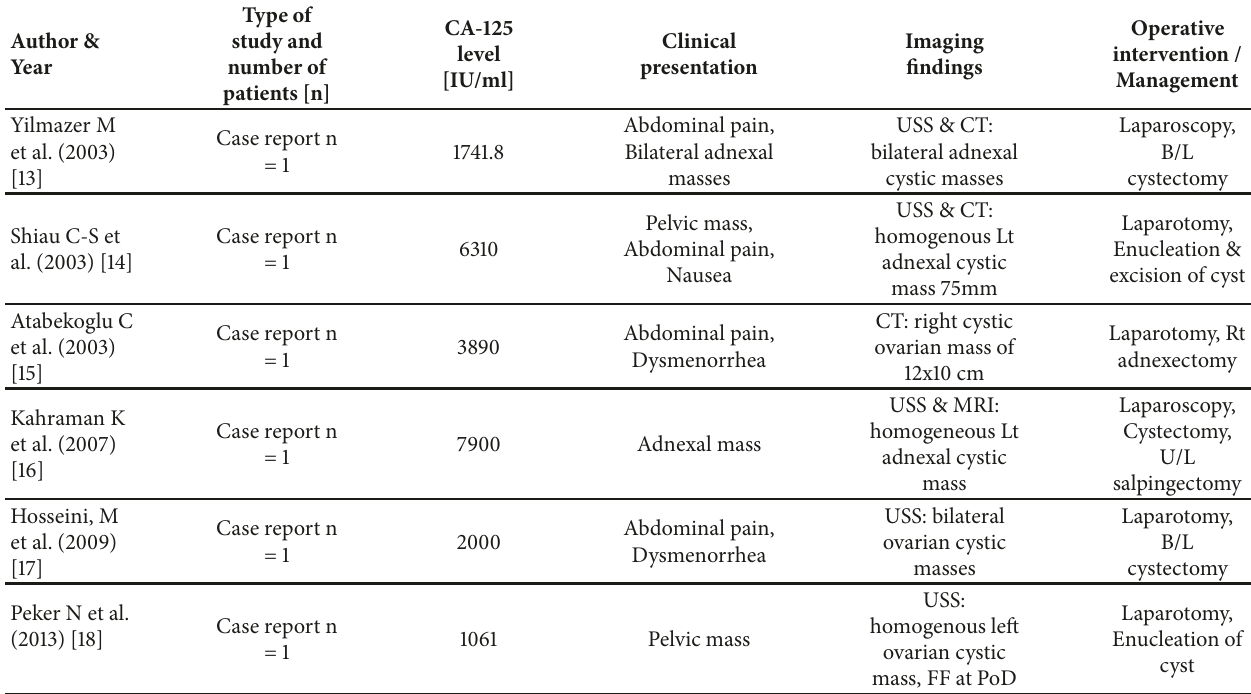
Table 2: Summary of cases of unruptured endometrioma with elevated CA 125 levels †